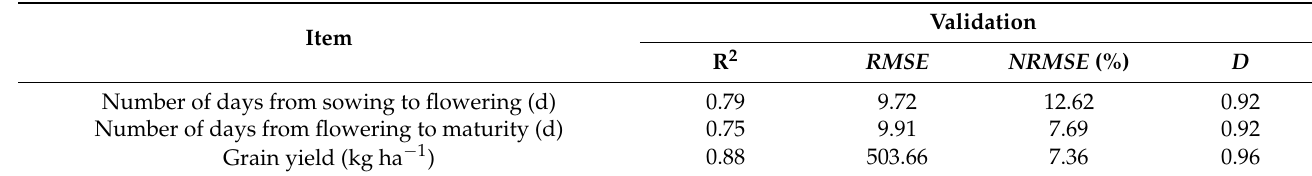
Figure 3. Validation results for the simulated number of days from sowing to flowering and from flowering to maturity as well as the maize grain yield after adjusting the parameters. ** Significant at p ≤ 0.05. Table 2. Validation results of the APSIM-Maize model in the study region.